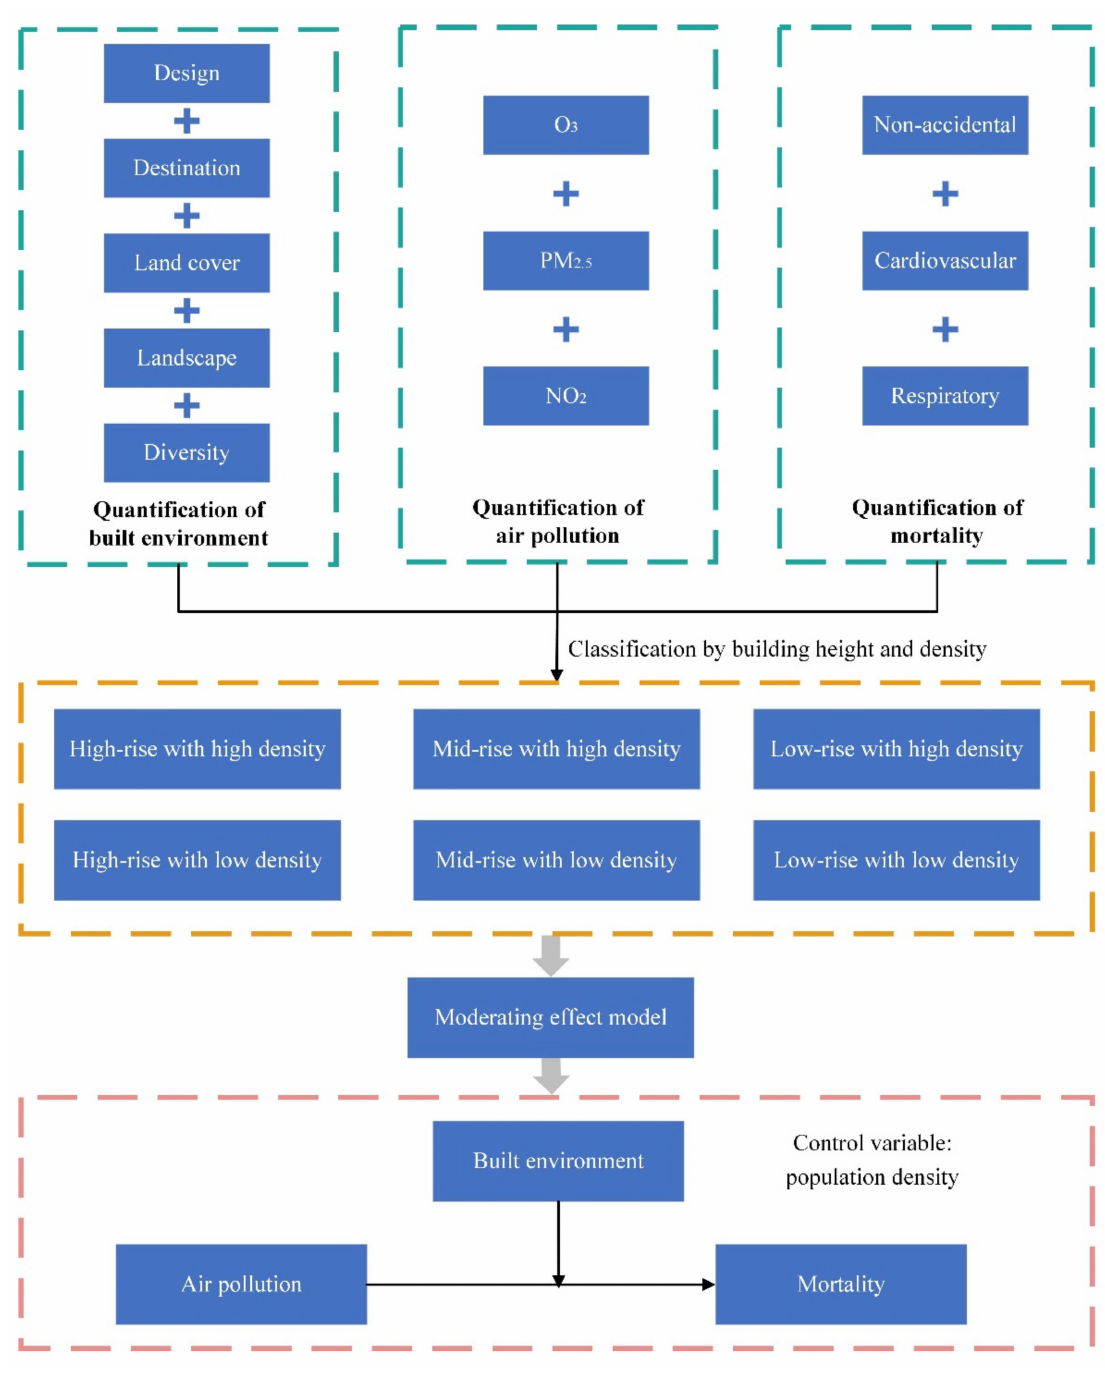
Figure 2. Overall framework of this